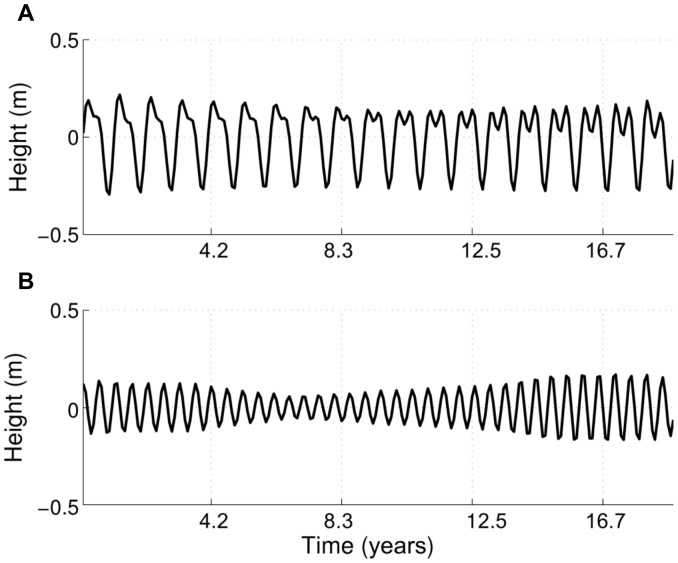
SSA reconstruction of wave dynamics.The first fundamental pair is shown in A and the second one in B.